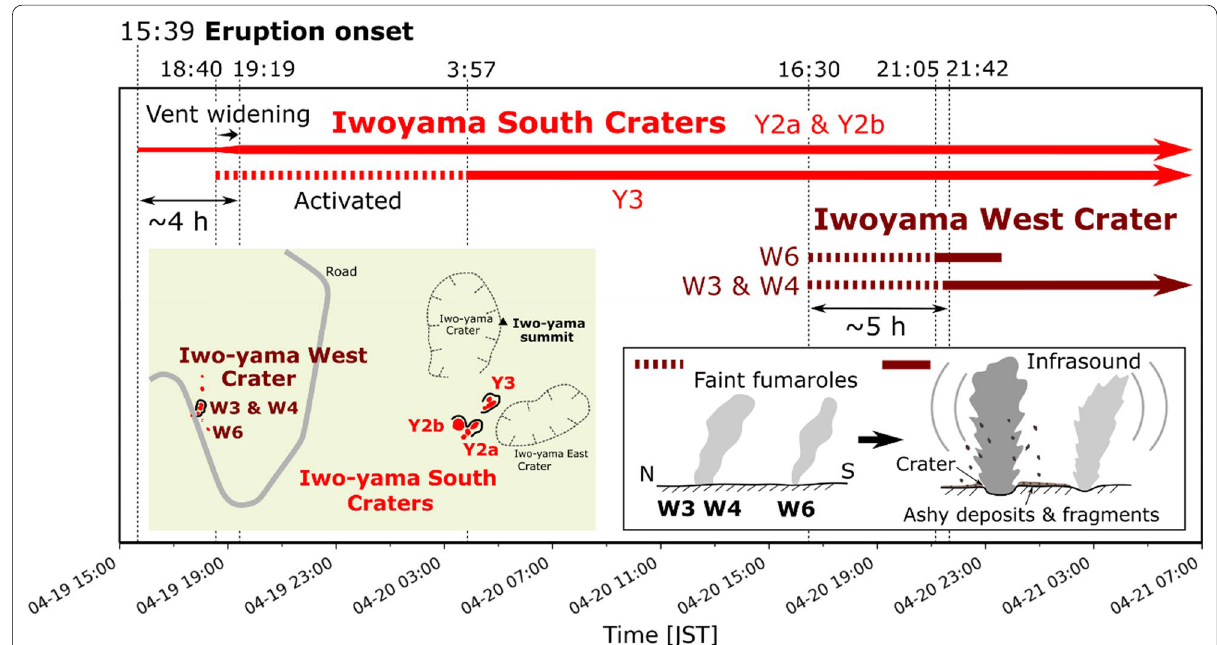
Fig. 5 Summary of the reconstructed sequence of the 2018 small phreatic eruption of Iwo-yama volcano. The eruption began at 15:39 on April 19 at Y2a in the South Crater area. The Y2a vent widened from 18:40, and then the eruption intensified from 19:19. Simultaneously with the vent widening, Y3 was activated and then became the main source of high-frequency infrasonic signals after 3:57 on April 20. Weak fumaroles appeared in the West Crater area around 16:30 on April 20. An eruption or gas emission started from 21:05 at W6. A small eruption emitting ash and ejecta occurred at 21:42 at W3–W4, resulting in the formation of a